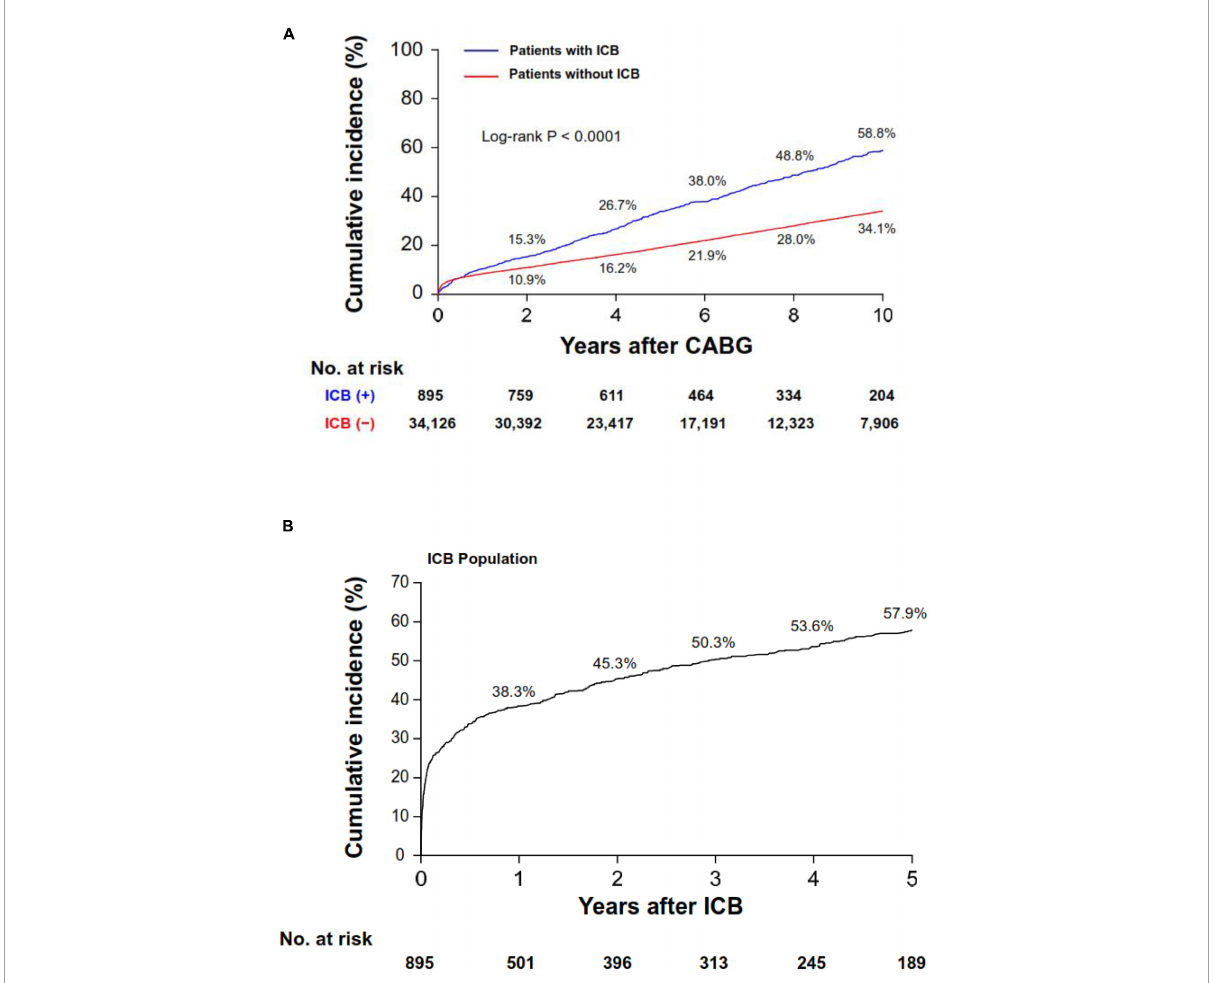
FIGURE2 Cumulative incidence of all-cause mortality. Cumulative incidence curves for mortality in the overall population (A) and in the ICB population (B) . Note that panel (B) shows the cumulative incidence curve starting from the ICB event. ICB, intracranial bleeding; CABG, coronary artery bypass grafting